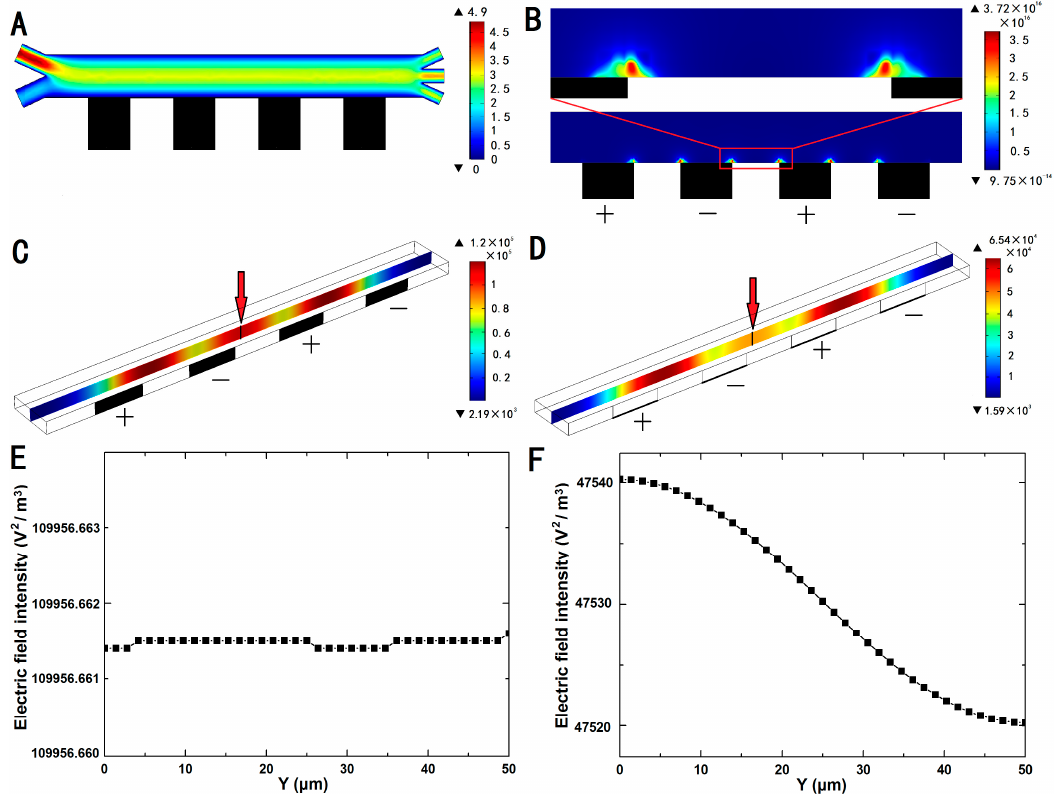
Figure 3. ( A ) Flow-field simulation of the separation process. The flow rates of inlets 1 and 2 are v 1 = 3 µ L / min and v 2 = 1 µ L / min, respectively. ( B ) Gradient of ∇| E rms | 2 near the electrode (Vpp = 20 V; the electric-field frequency was 1 MHz). Distribution of the electric-field intensity on the vertical section of separation channel, ( C ) 3D and ( D ) planar electrodes. The electric-field intensity of the line in the middle of vertical section from the bottom (Y = 0- µ m) to top (Y = 50- µ m), ( E ) 3D and ( F ) planar